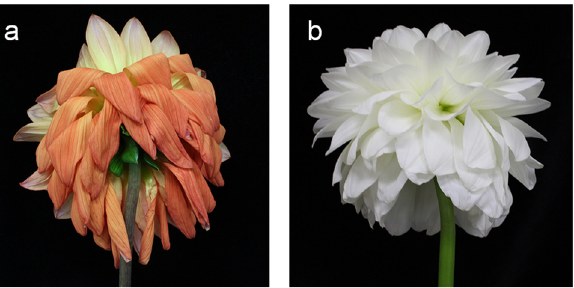
Figure 1. Inflorescence with petals in the wilting process. ( a ) ‘Carnelian’; ( b )